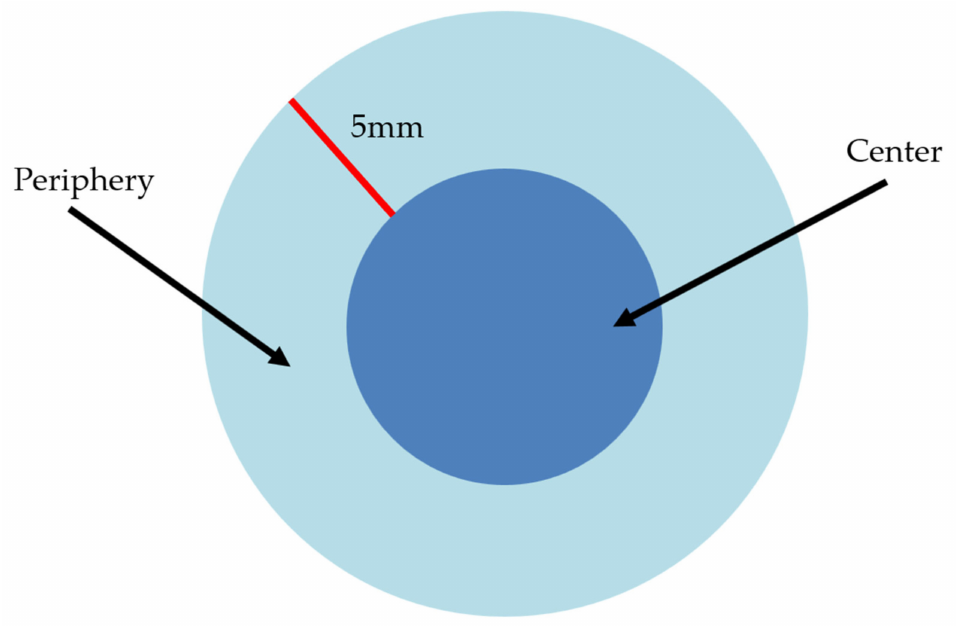
Figure 1. Schematic definitions of the center and periphery of a gastric gastrointestinal stromal tumors (GISTs) during pathological